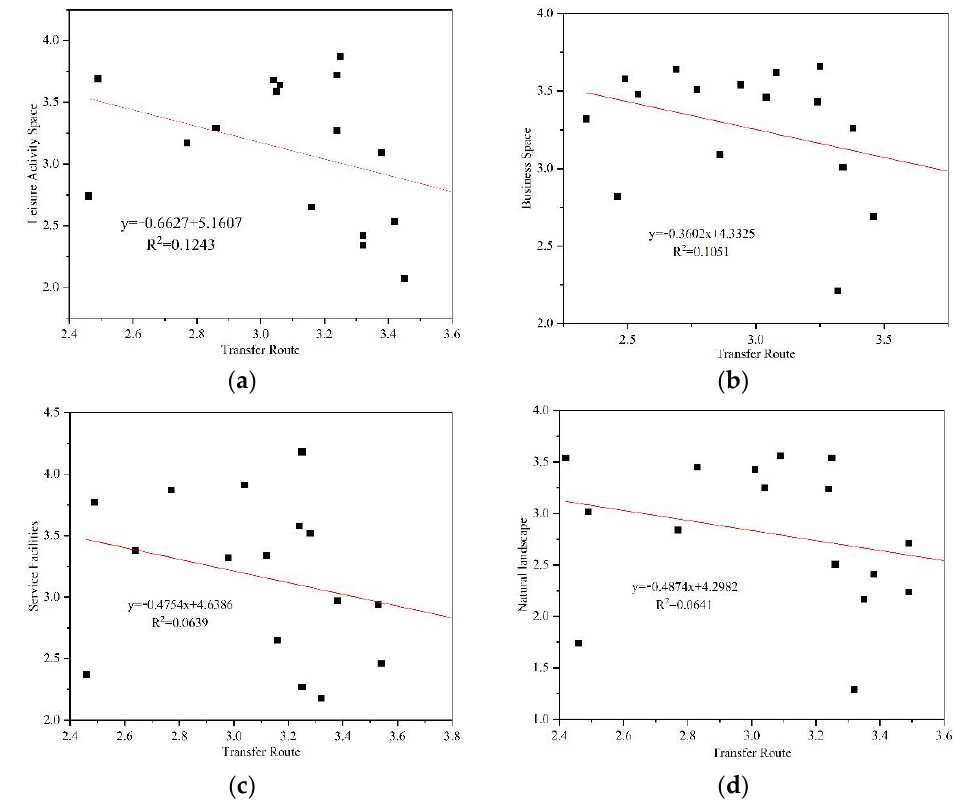
Figure 19. ( a ) Relevance of transfer route and leisure activity space; ( b ) relevance of transfer route and business space; ( c ) relevance of transfer route and service facilities; ( d ) relevance of transfer route and natural